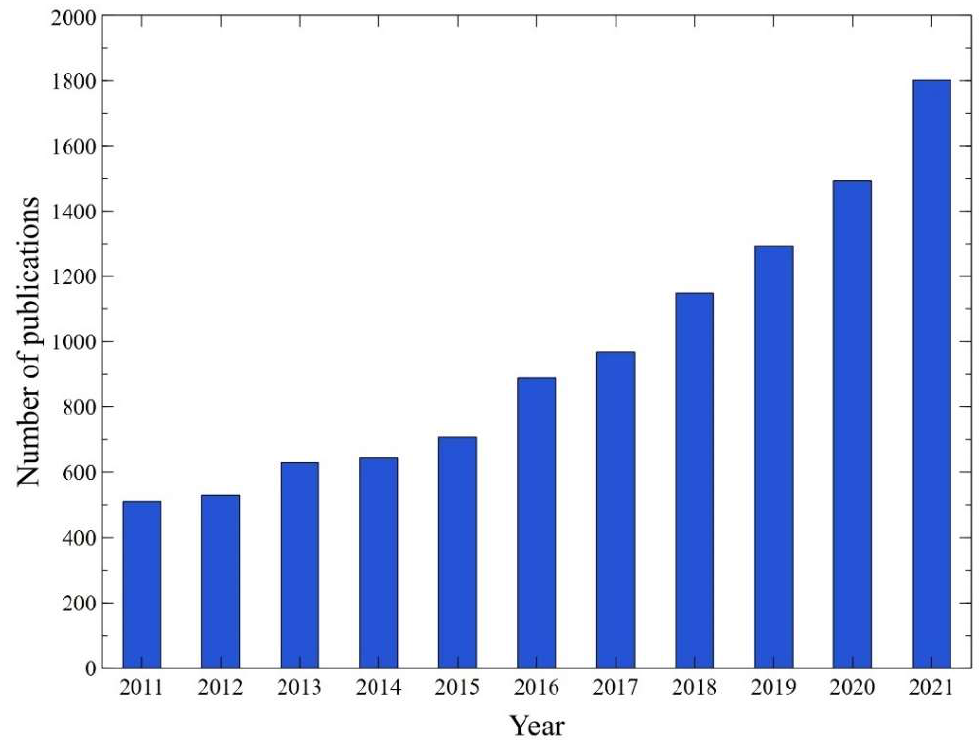
Figure 1. The number of research papers focused on MBRs according to Science Direct. Keyword: membrane bioreactor. Data retrieved: 19 April 2022.